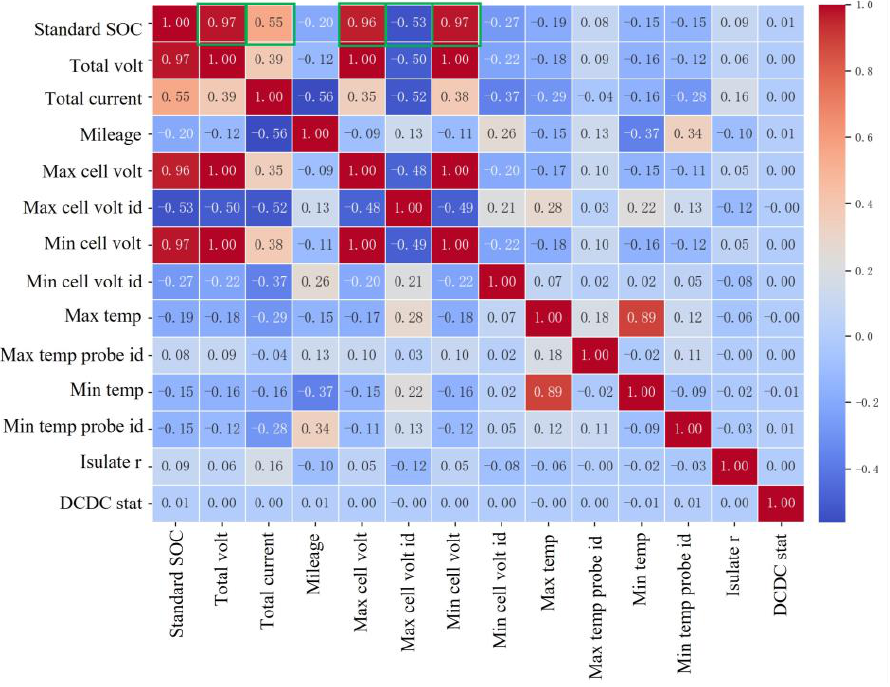
Figure 5. Heat map analysis of parking and charging correlation coefficients.